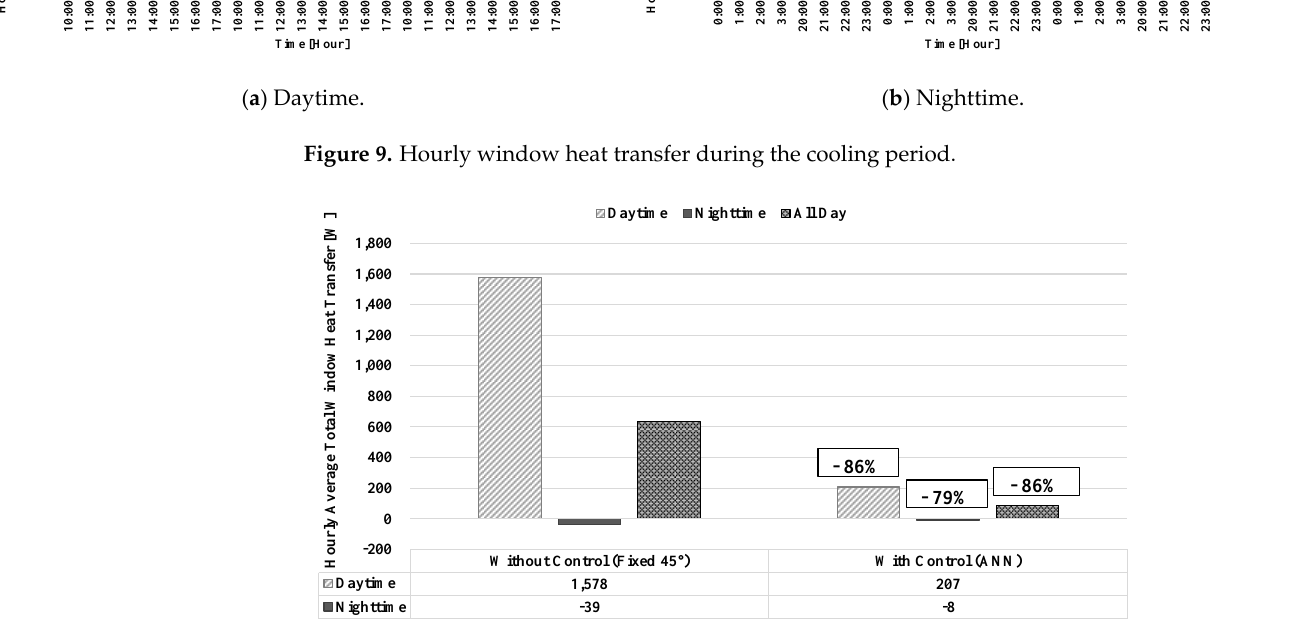
Without Control (Fixed 45°)